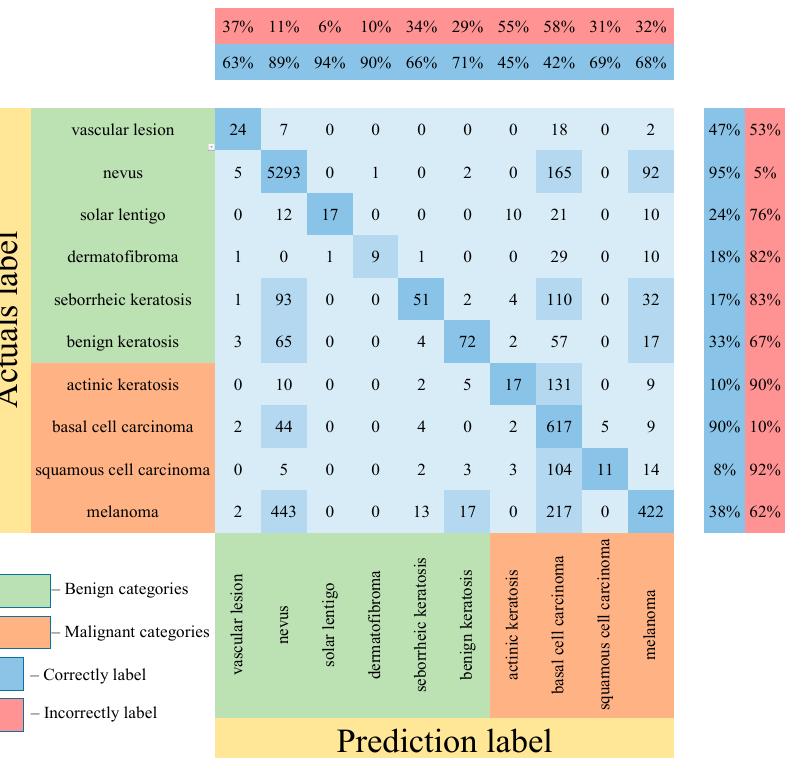
Figure 15. Confusion matrix in the testing results in a multimodal neural network system for recog ‐ nizing pigmented skin lesions based on CNN ResNet ‐ 101.